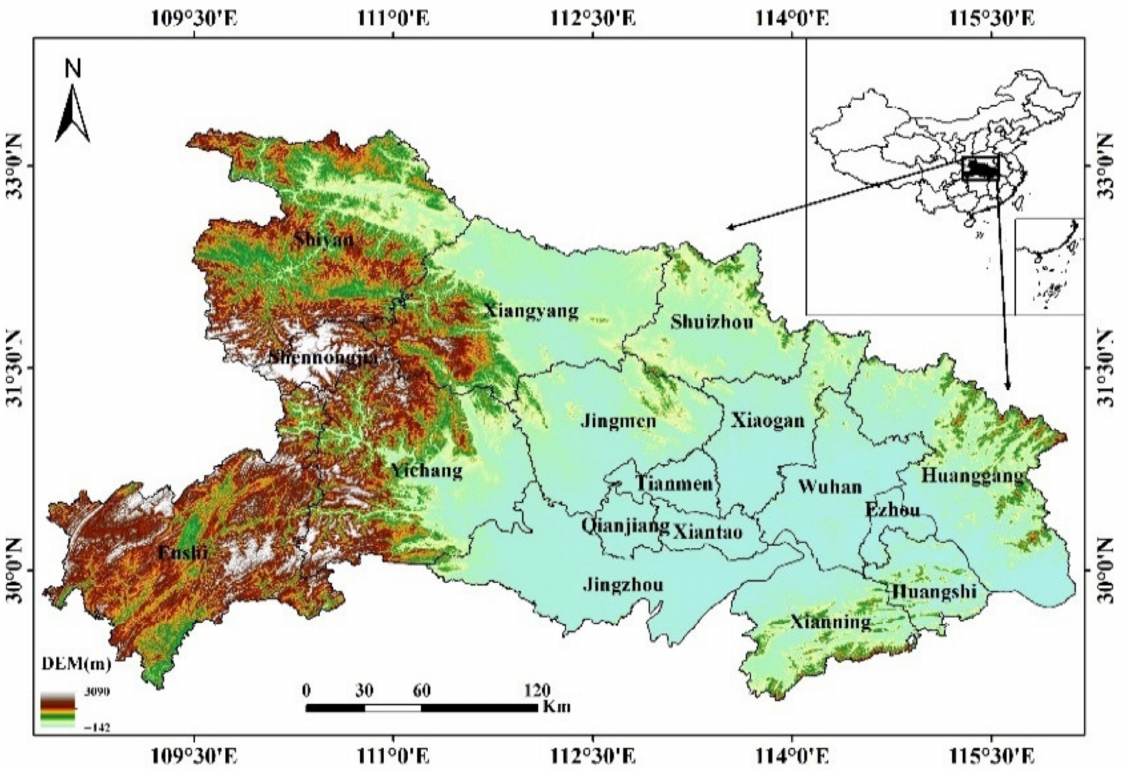
Figure 1. Distribution of elevation and geographical location in Hubei